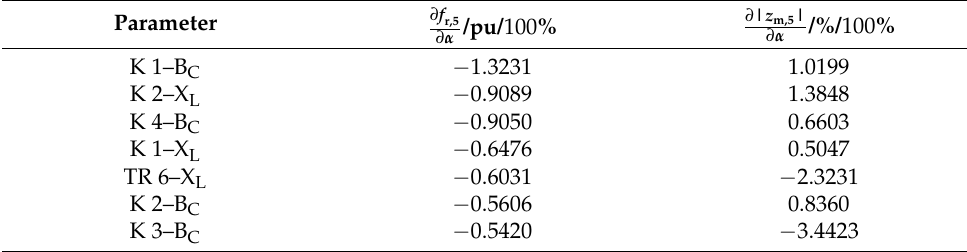
Figure 9. Bus 7 impedance change. The relations between bus 6 and 7 impedances shown in Figures 8 and 9 are presented in Figure 10 at the 7th harmonic frequency (350 Hz). The values presented are normalized to the impedance magnitudes at the nominal network frequency. The impedance after the parallel resonance frequency shift with parameter change is lower, which means that the parallel resonance mitigation at the 7th harmonic frequency was successful.